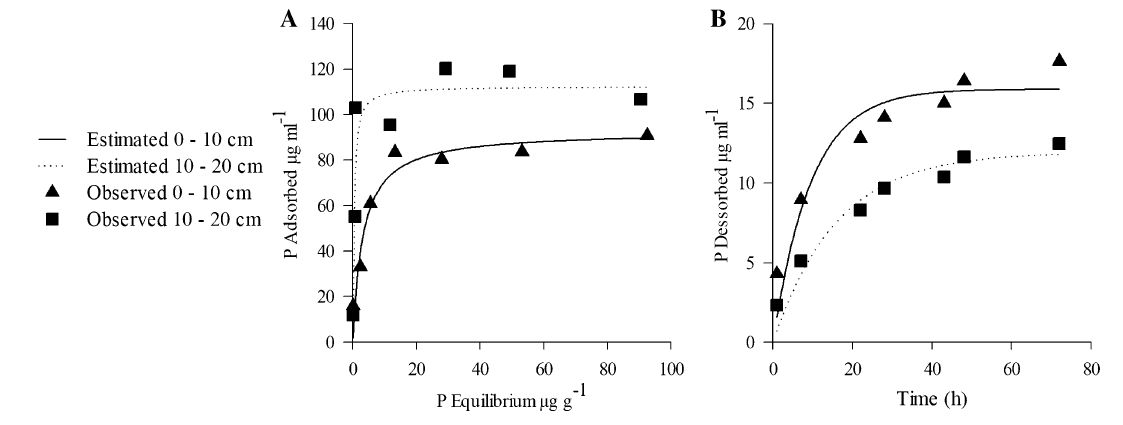
Table 7 Desorption parameters (Fe strips) and Langmuir isotherms adjusted for the depths of Dystric Xeropsamments in nonlinear regression Depths cm